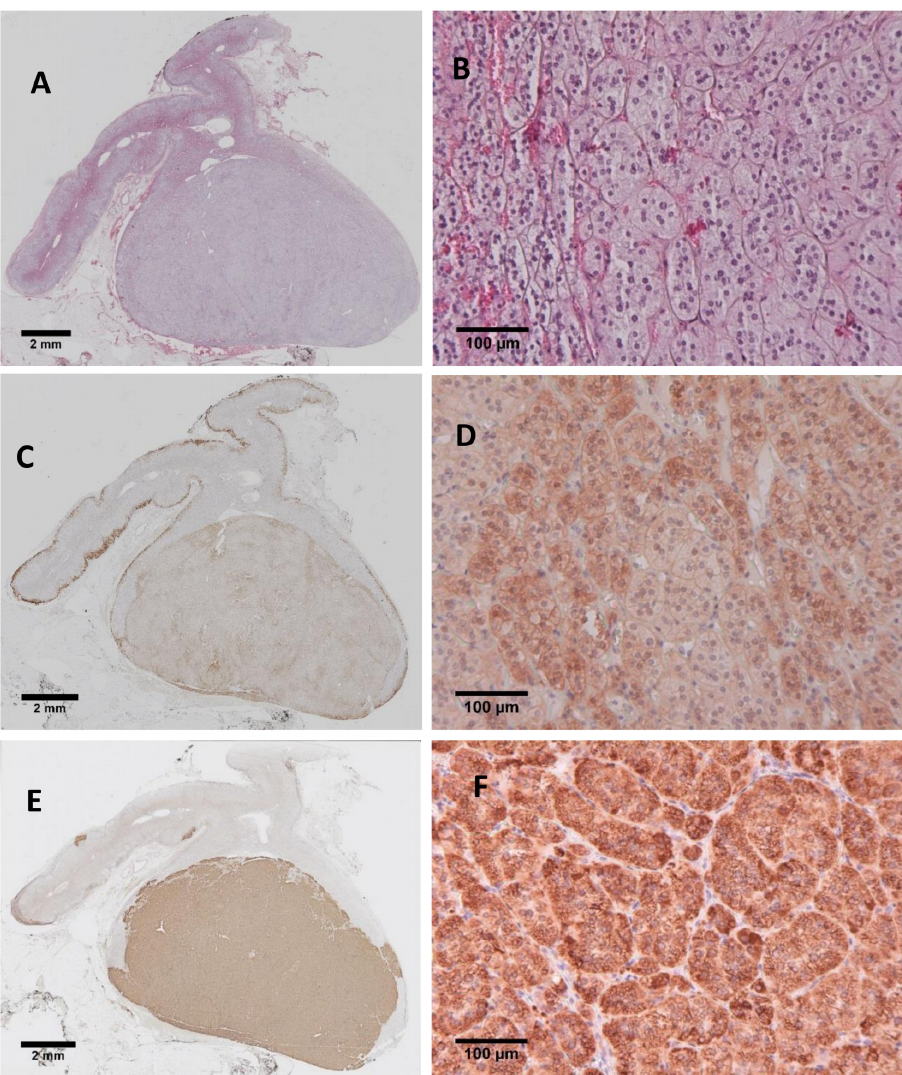
Figure 3. VSNL1 and CYP11B2 immunohistochemistry. An aldosterone-producing adenoma with a KCNJ5 mutation stained with haematoxylin and eosin panels ( A , B ); immunostained for VSNL1, panels ( C , D ); and for CYP11B2 panels ( E , F ). The VSNL1 antibody was from Merck and the